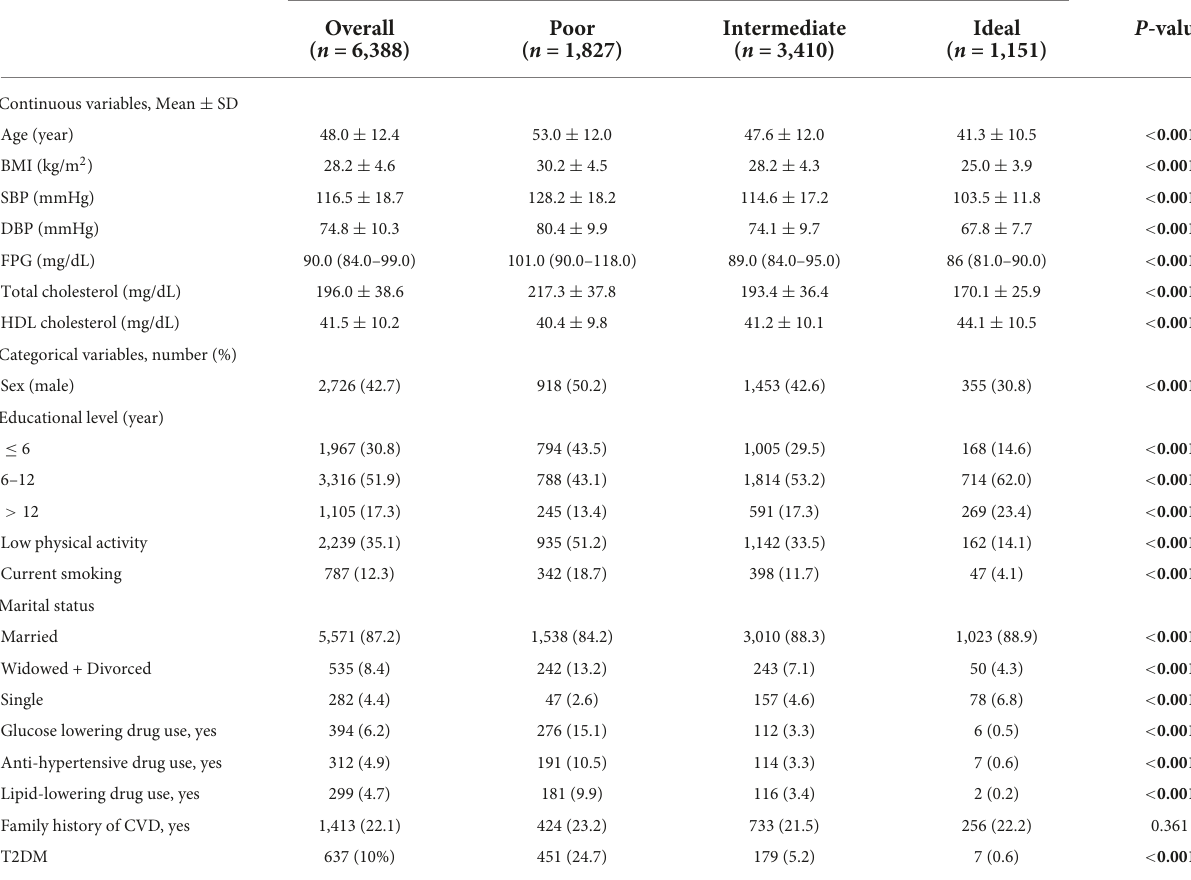
TABLE 1 Baseline characteristics by global cardiovascular health status, Tehran Lipid and Glucose Study (TLGS),